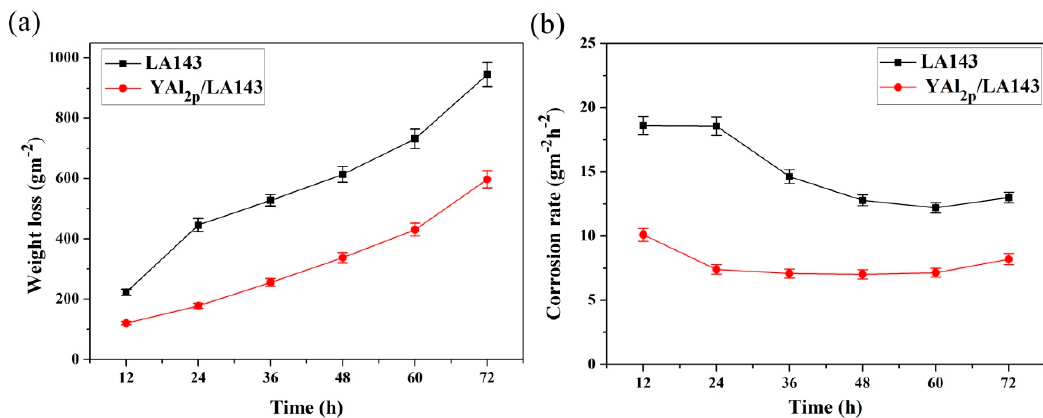
Figure 2. Curves of the LA143 alloy and YAl 2p /LA143composite corrosion at 298 K for 72 h in 3.5 wt.% NaCl solution. ( a ) Weight loss versus time and ( b ) corrosion rate versus time.